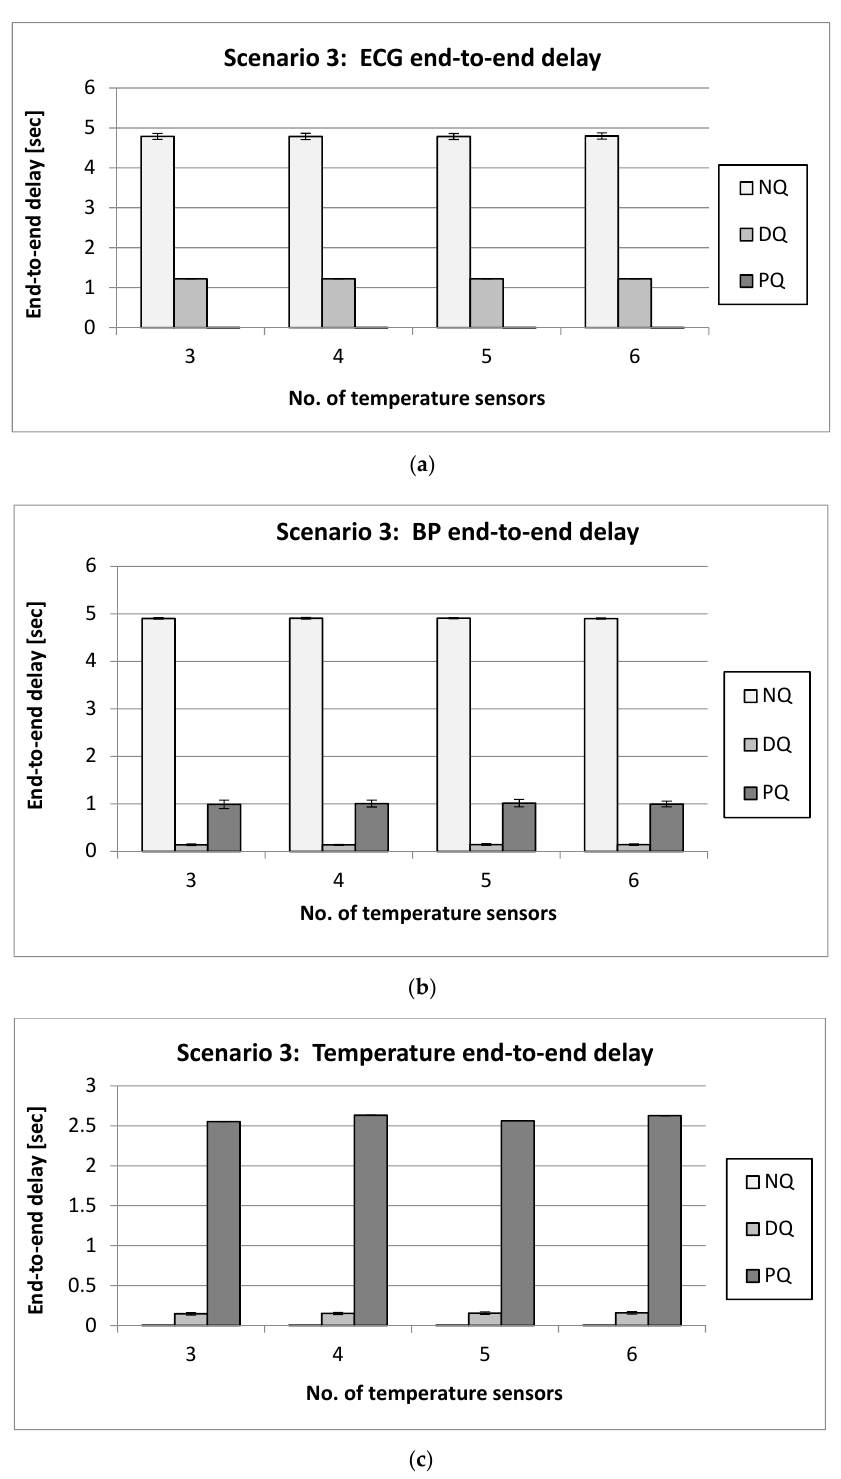
Figure 10. Average end-to-end packet delay results comparison for various data traffic types .